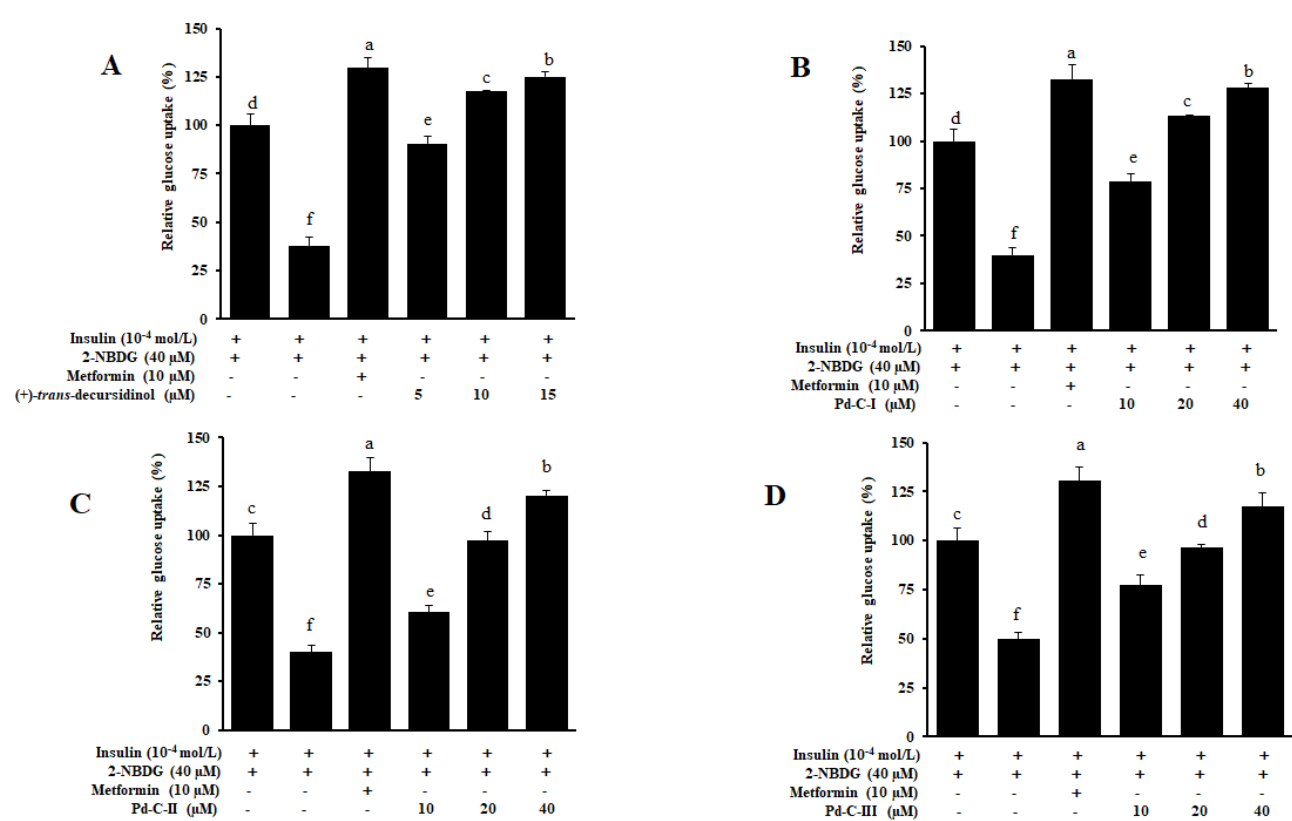
Figure 4. Effect of dihydroxanthyletin-type coumarins on insulin-stimulated glucose uptake in insulin-resistant HepG2 cells. The use of fluorescent D-glucose analogue 2-[N-(7-nitrobenz-2-oxa-1, 3-diazol-4-yl) amino]-2-deoxy-D-glucose (2-NBDG) was tested for glucose uptake; insulin at 10 − 4 mol/L was utilized to induce insulin resistance. Different concentrations of dihydroxanthyletin-type coumarins or metformin were treated with cells for 24 h, and insulin-stimulated 2-NBDG uptakes were assessed for 24 h. a – f Different letters indicate statistical differences among means of each metformin and dihydroxanthyletin- type coumarins concentrations. Results were analyzed by ANOVA and Duncan’s test ( p < 0.05).